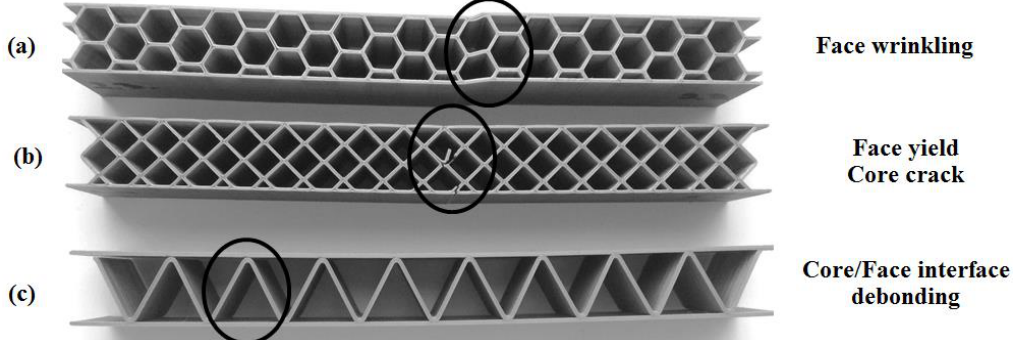
Figure 10. Failure mechanisms of sandwich specimens obtained from the three-point bending test: ( a ) honeycomb core; ( b ) diamond-cell core; ( c ) corrugated core.